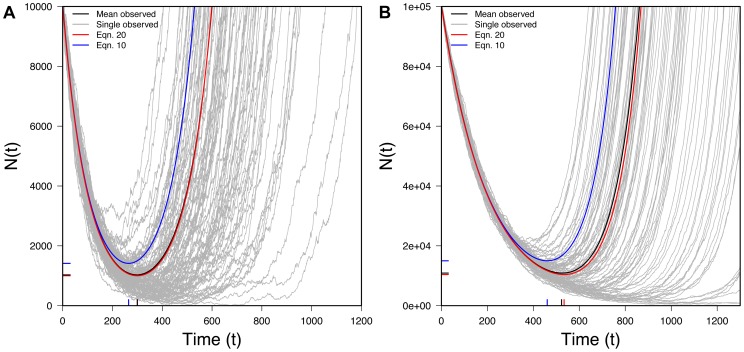
The U-shaped curve for populations rescued by new mutation.100 randomly selected successful realizations in gray, mean of all successful realizations in black, Eq. 19 (expectation from new mutation) in red, Eq. 10 (expectation from standing variation) in blue. Ticks on X-axis represent observed (black) and predicted (red) tmin (Eq. 21) while ticks on the Y-axis represents observed (black) and predicted (red) Nmin (Eq. 22). A) N0 = 10,000, r = 0.01, s = 0.02, u = 10−5 B) N0 = 100,000, r = 0.005, s = 0.015, u = 10−6; 10,000 realizations.